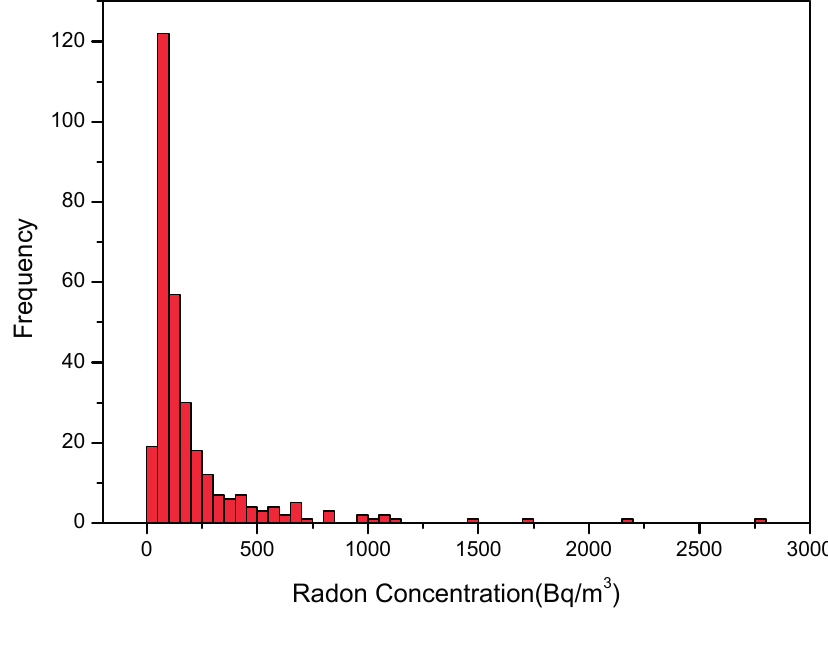
Figure 2. Frequency distribution of indoor radon concentrations in Peninsula Salentina dwellings.